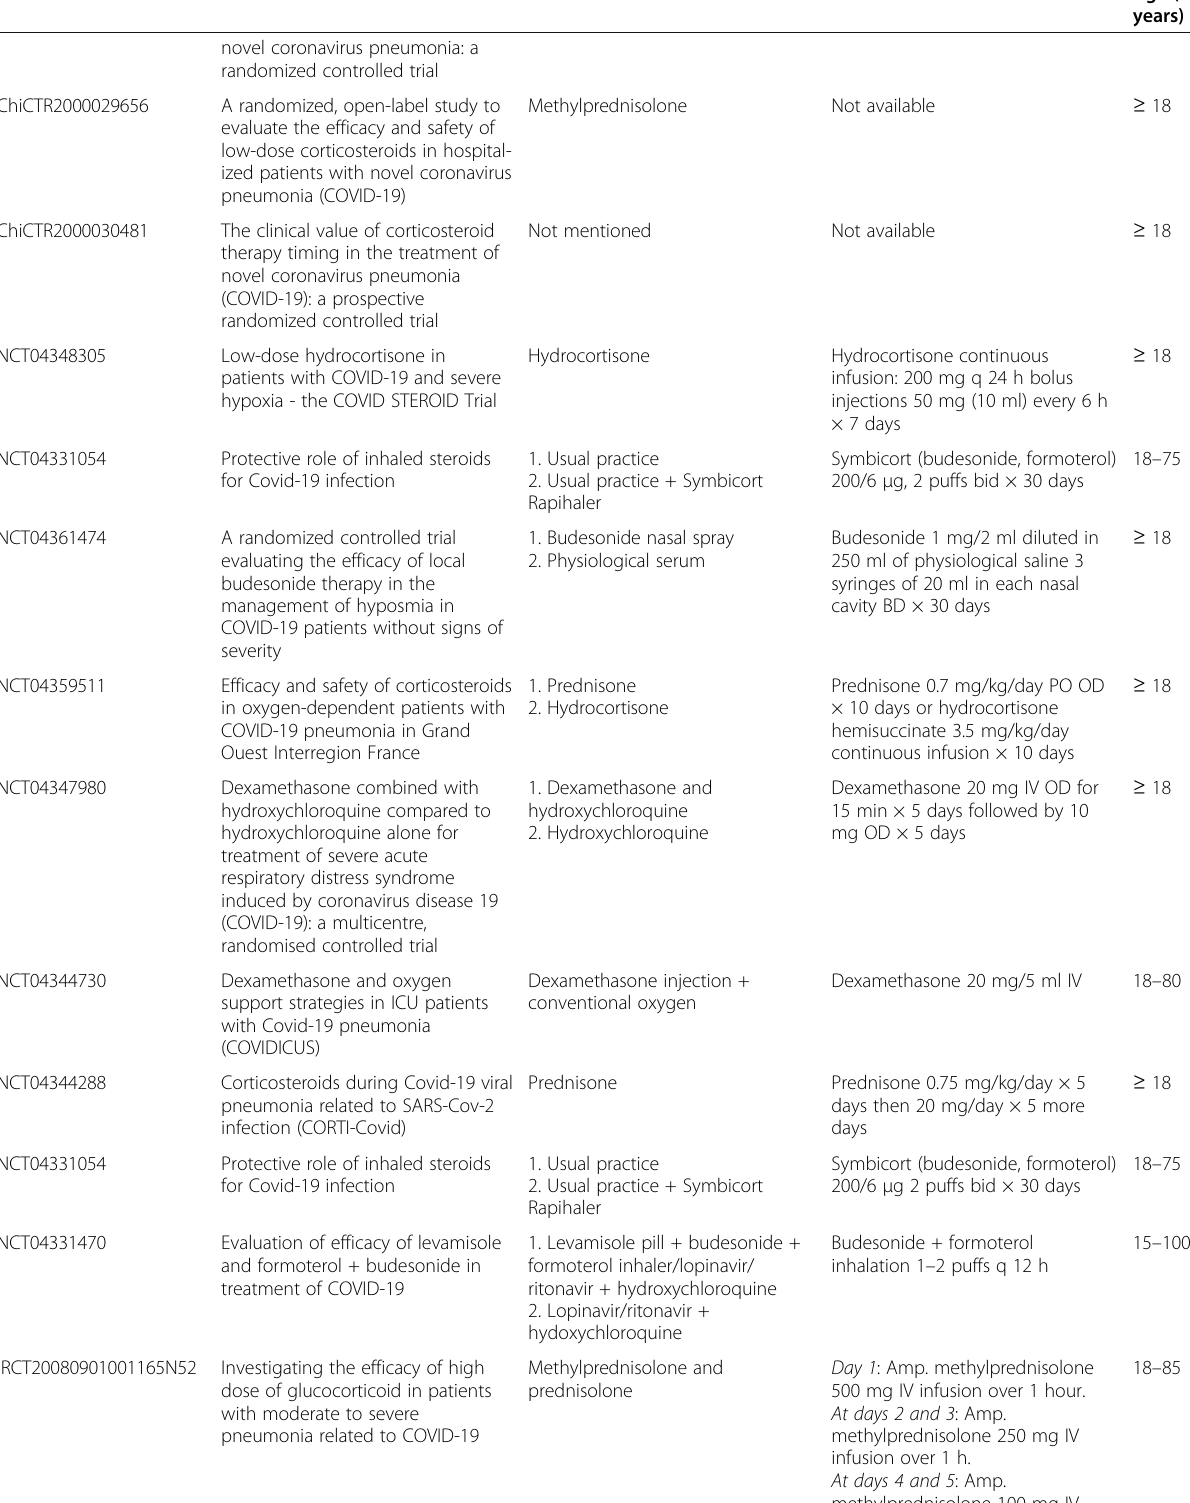
Table 3 Steroid treatment in patients with COVID-19 (Continued) Trial